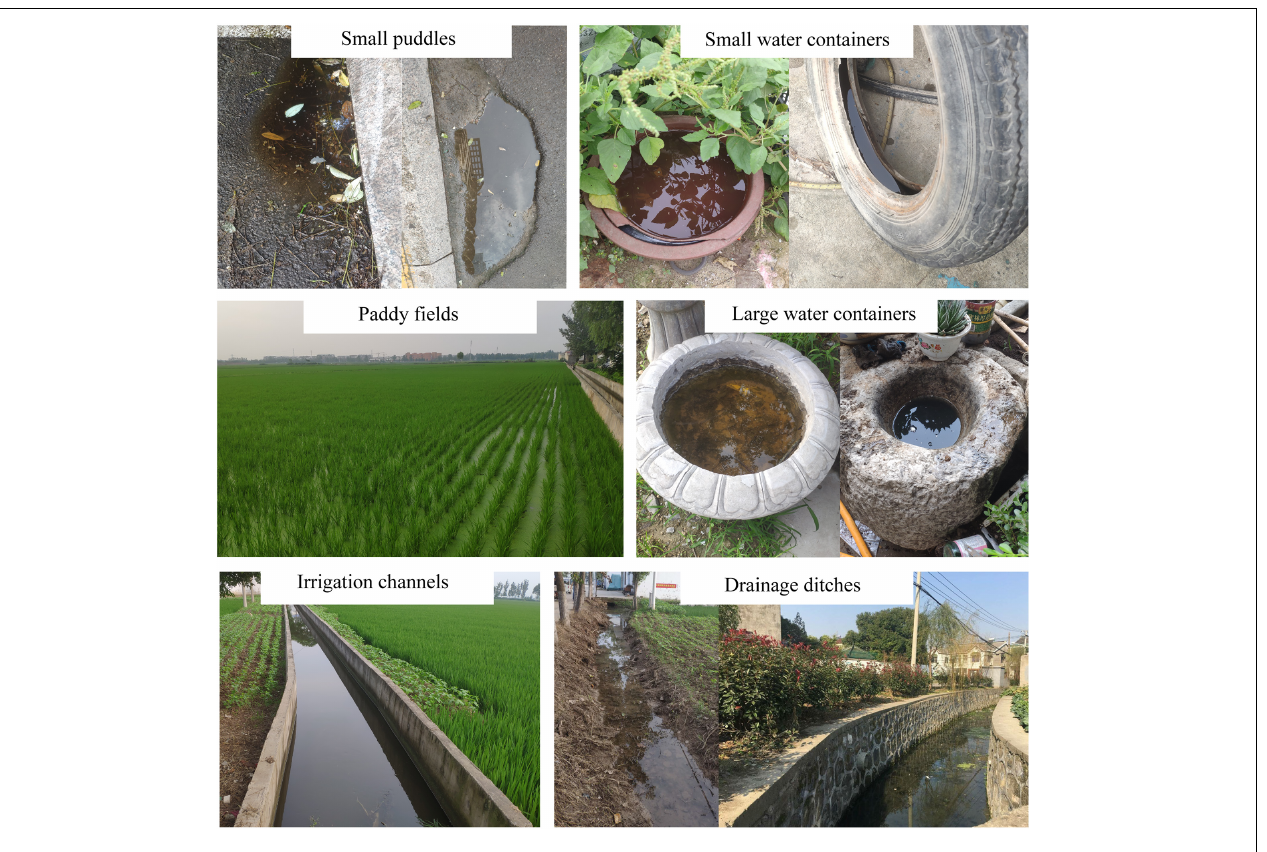
FIGURE 2 | Representative images from the larval habitats in Jiaxiang County. TABLE 1 | Number and density of each species in different habitat